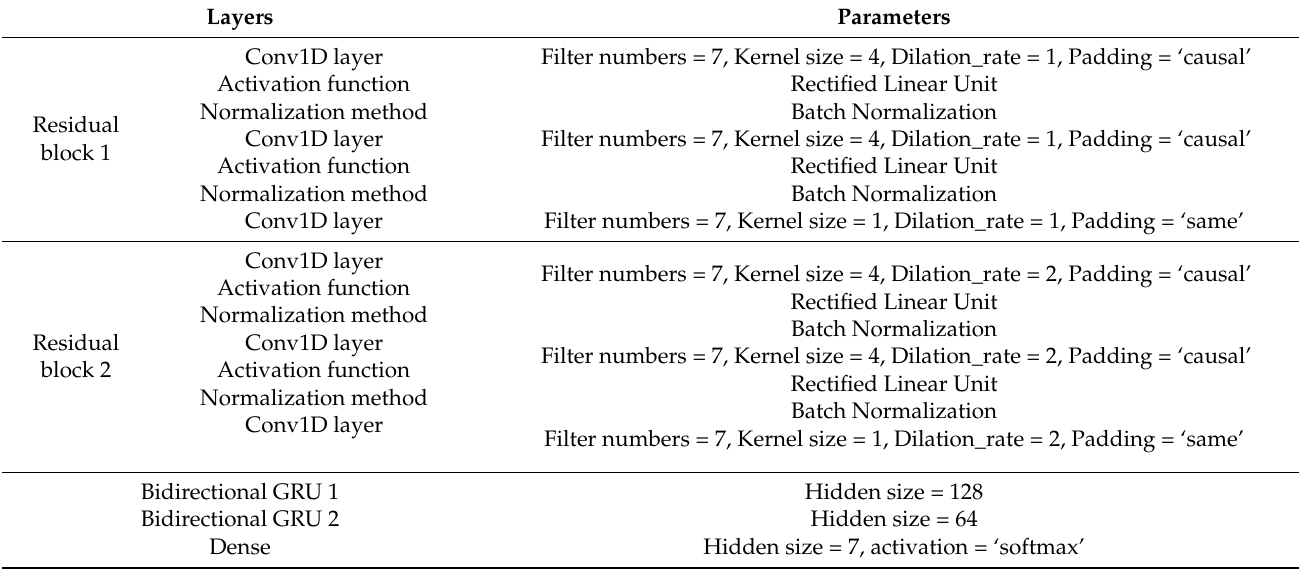
Table 8. Parameters of each layer of the proposed